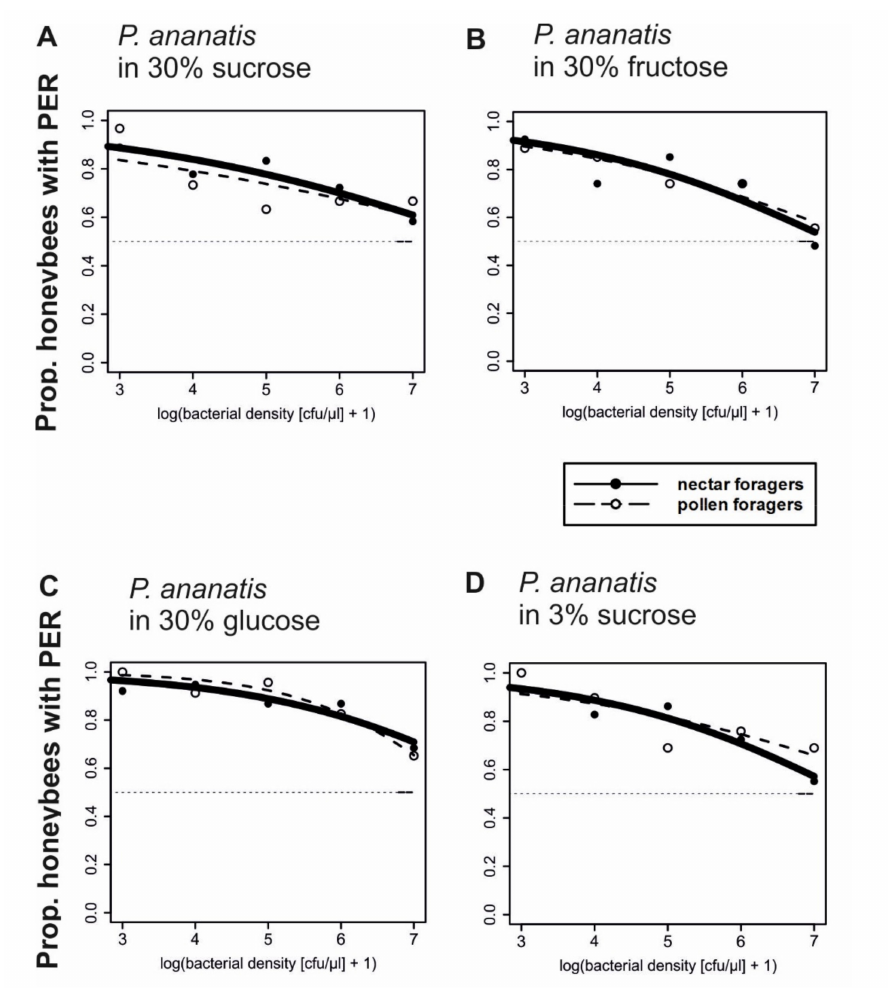
Figure 1. Proportion of honeybee nectar and pollen foragers accepting di ff erent aqueous sugar solutions containing variable densities of P. ananatis bacteria and responding with proboscis extension response (PER) to antennal stimulation. Regression lines represent the logistic functions on binary data of occurrence of PER: ( A ) 36 nectar foragers and 30 pollen foragers; ( B ) 27 nectar foragers and 27 pollen foragers; ( C ) 31 nectar foragers and 30 pollen foragers; ( D ) 29 nectar foragers and 29 pollen